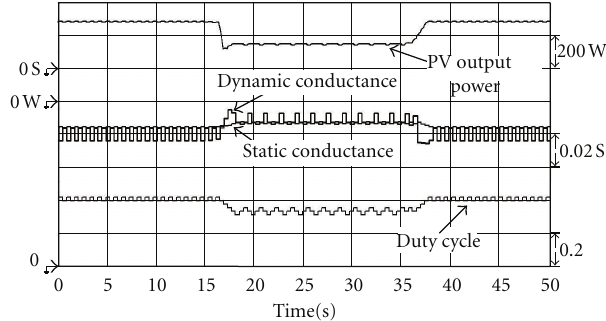
Figure 9: Simulated output power, dynamic conductance, static conductance, and duty cycle waveforms of a PV module array using the traditional INC method under irradiation that dropped from 1,000 W/m 2 to 700 W/m 2 , and then increased back up to 1,000 W/m 2